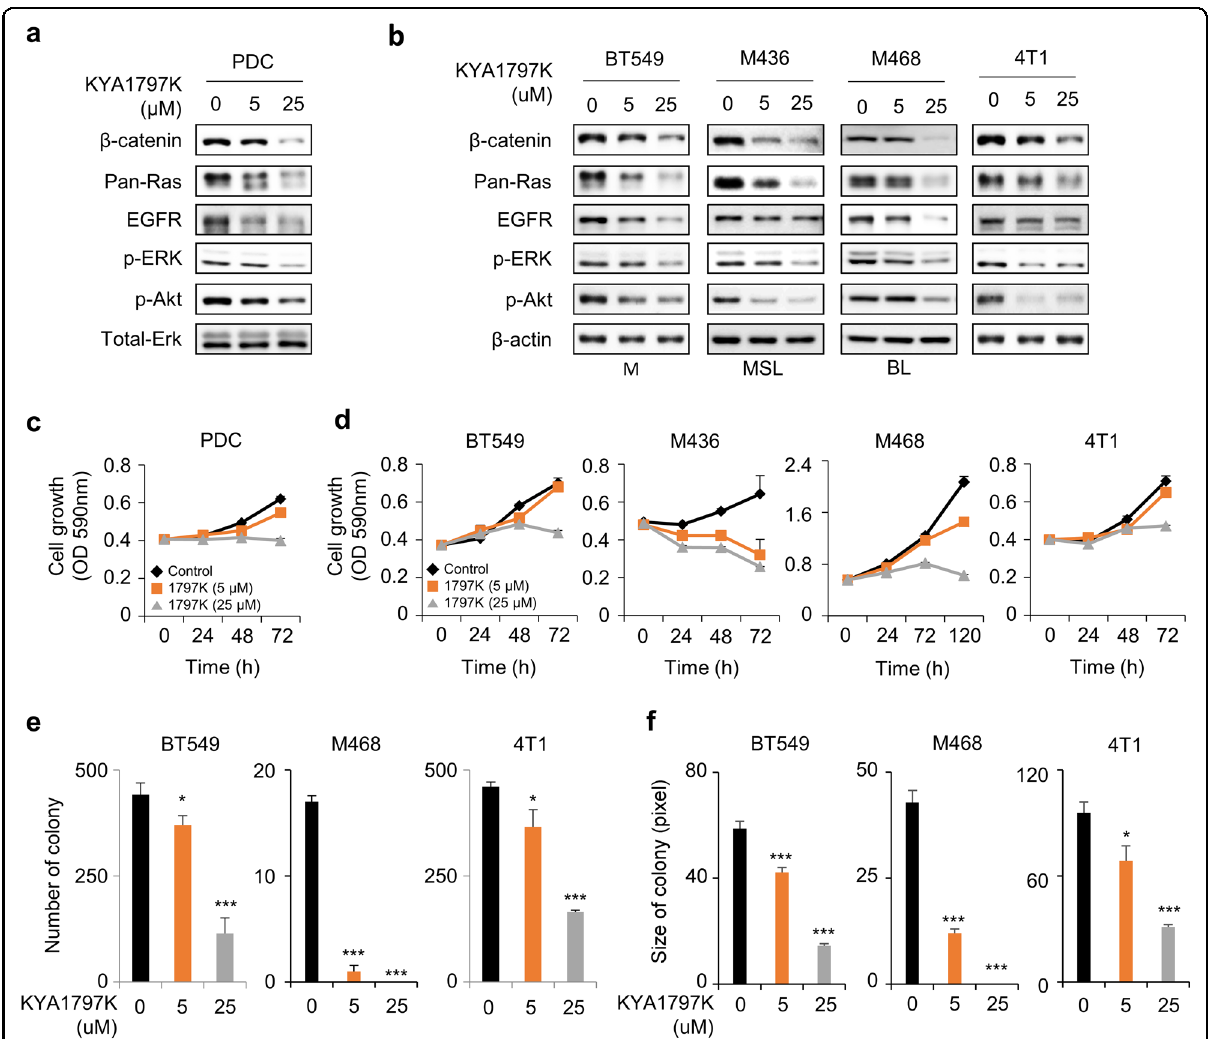
Fig. 2 Effects of KYA1797K on TNBC PDCs and cell lines. a , b TNBC cells were cultured and treated with 5 or 25 µM KYA1797K for 24 h. Immunoblot analyses of whole-cell lysates (WCLs) with the indicated antibodies. c , d PDCs, human TNBC cell lines, and 4T1 mouse TNBC cells were dose-dependently treated with KYA1797K. Cell proliferation was measured and quanti fi ed using MTT assay ( n = 3). e , f Colony-formation assay was performed in TNBC cells treated with 5 or 25 µM KYA1797K for 14 days. The colonies in e and f were photographed and quanti fi ed from independent experiments (mean ± SEM; n = 3) based on two-sided Student ’ s t test between control and experimental samples, respectively. * P < 0.05, ** P < 0.005., *** P < 0.0005. M = mesenchymal-like, MSL = mesenchymal stem-like, BL =